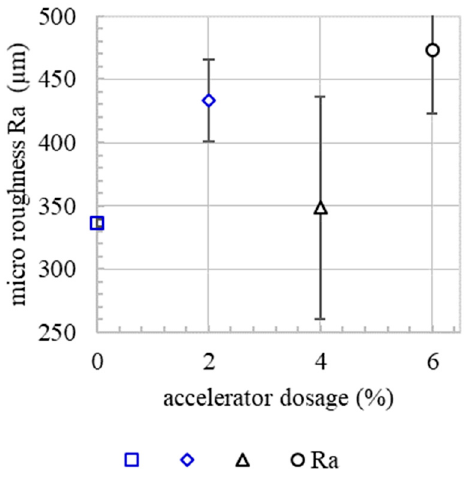
Figure 10. Micro roughness of the surface layer of specimen containing 0% (a0), 2% (a2), 4% (a4) and 6% (a6) of